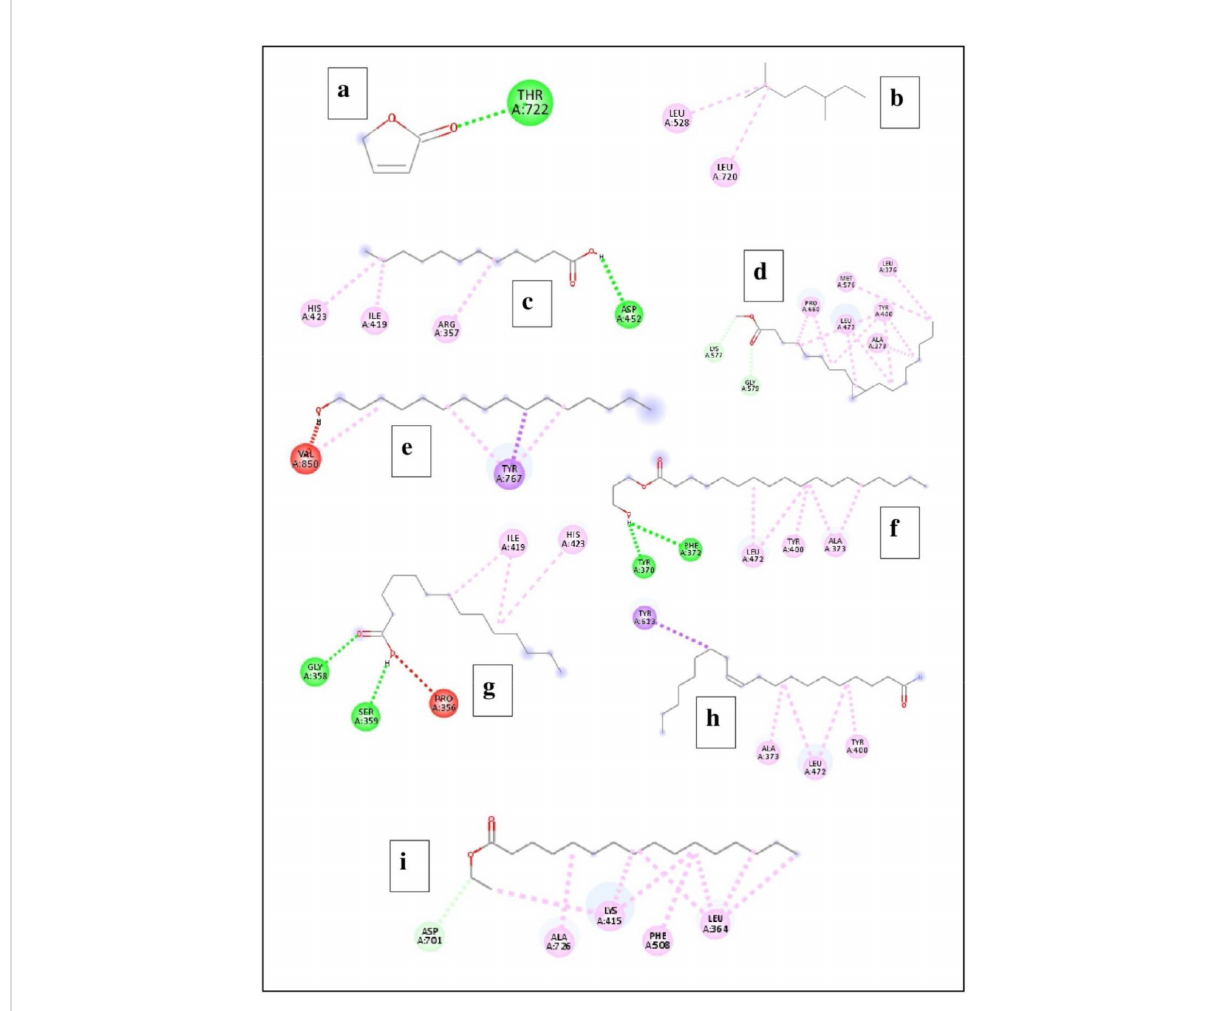
FIGURE 5 The interaction of compounds identi fi ed in the extract from the culture supernatant of Alcanivorax sp. AA8 with the target bio fi lm-associated protein (BAP). (A) Butenolide; (B) Heptane, 2,5-dimethyl; (C) Dodecanoic acid; (D) Cyclopropaneoctanoic acid, 2-octyl-, methyl ester; (E) 1-Hexadecanol; (F) Octadecanoic acid, 3-hydroxypropyl ester; (G) Tetradecanoic acid; (H) Cis-11-eicosenamide; and (I) Hexadecanoic acid, ethyl